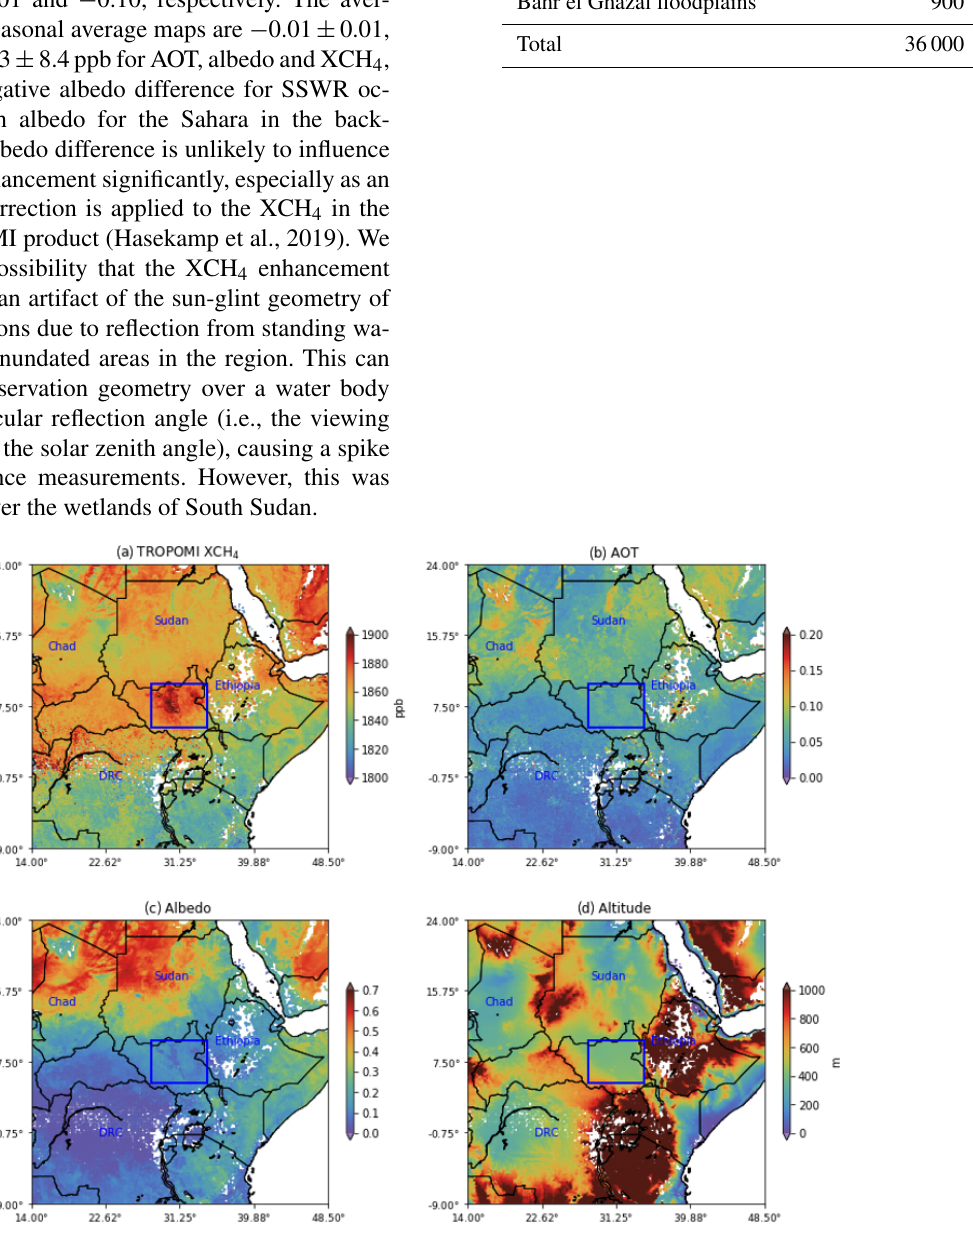
Figure A1. Average TROPOMI data (2018–2019) at 0.1 ◦ × 0.1 ◦ resolution. The albedo and AOT are retrieved for the SWIR band at 2.3µm.